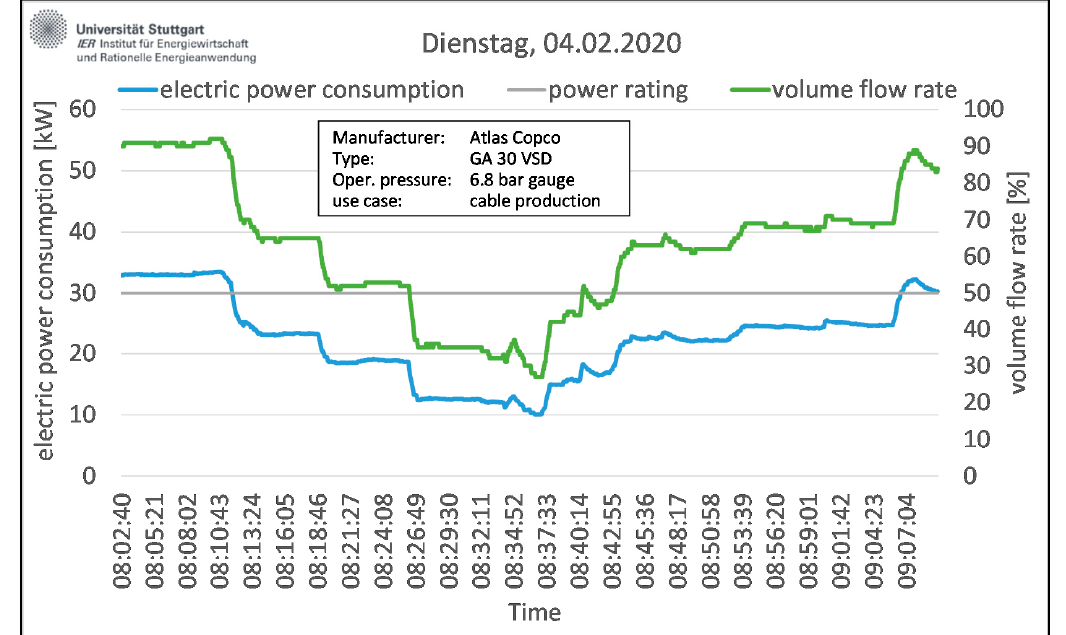
Figure 2. Electric power demand and percentage of maximum volume flow rate over time (source: own representation).